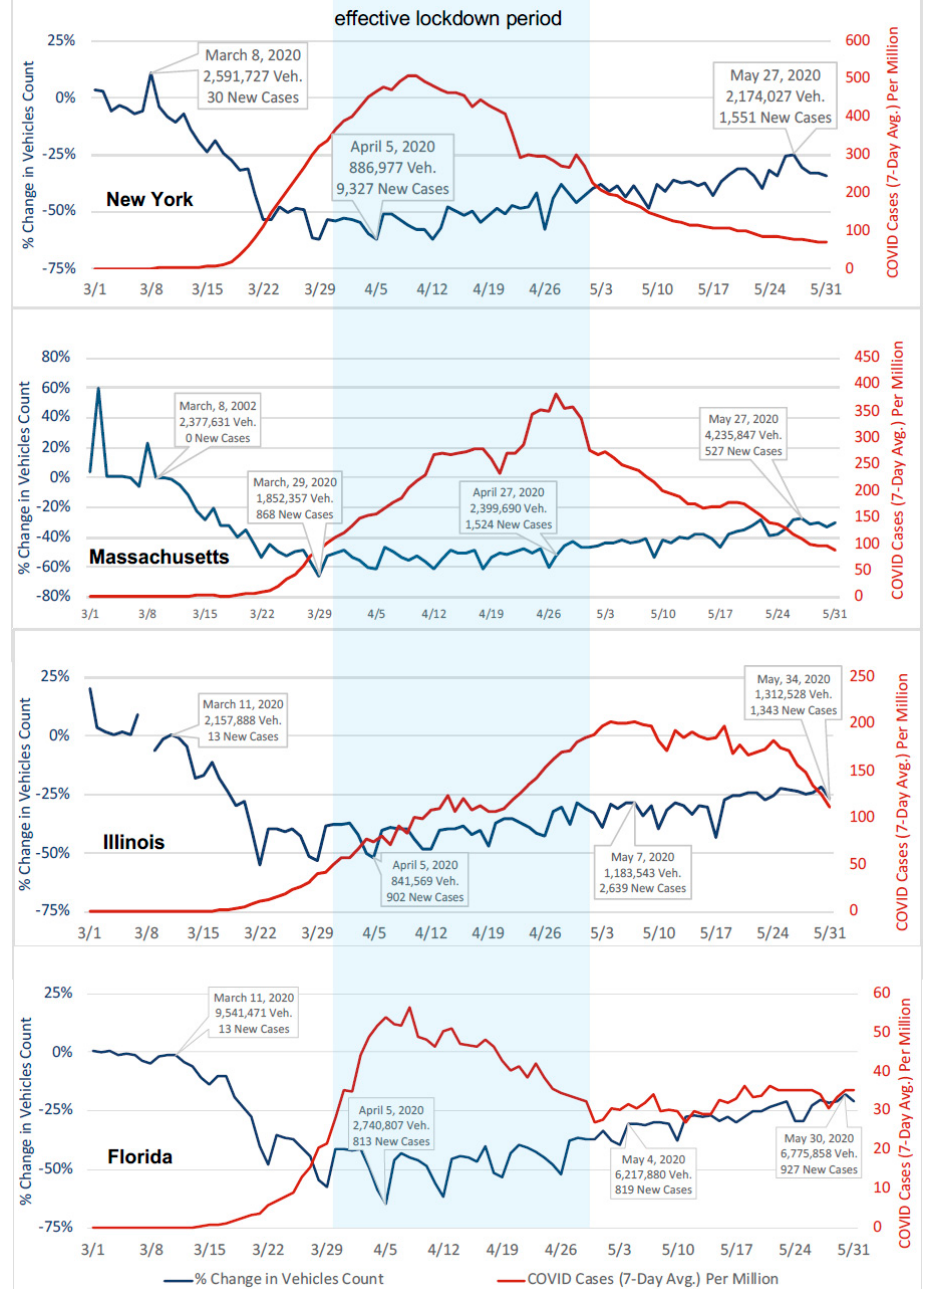
Figure 2. Seven day rolling average of new COVID-19 cases per million in population and change in Table 2020 vs 2019).